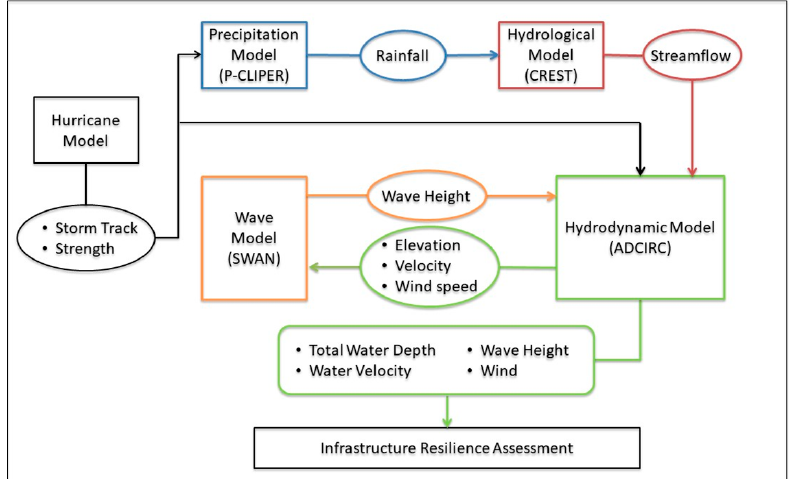
Figure 1. Schematic of the STORM-CoRe coupled modeling system: Models are shown in boxes, model output in ovals, and arrows indicate the information that is passed to each model as input. All information that is passed to the Infrastructure Resilience Assessment modeling team passes through the ADCIRC model and is denoted by the rounded rectangle.